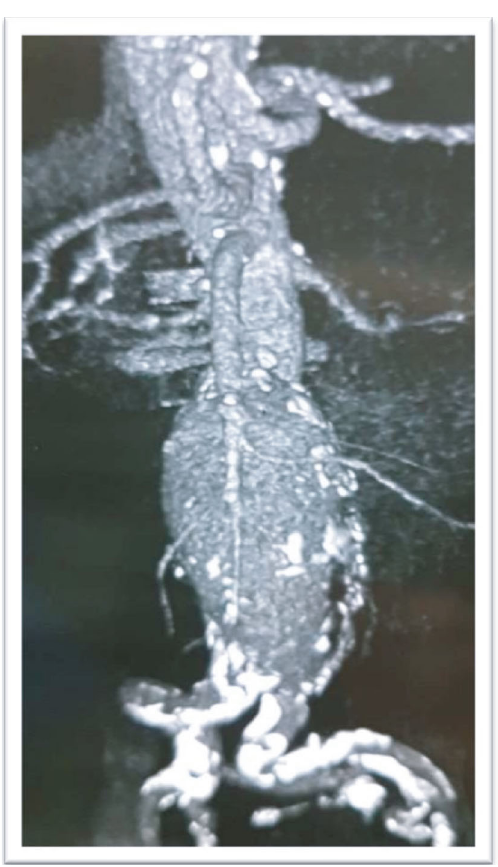
Figure 1: Abdominopelvic CT scan without contrast before AAA repair operation.